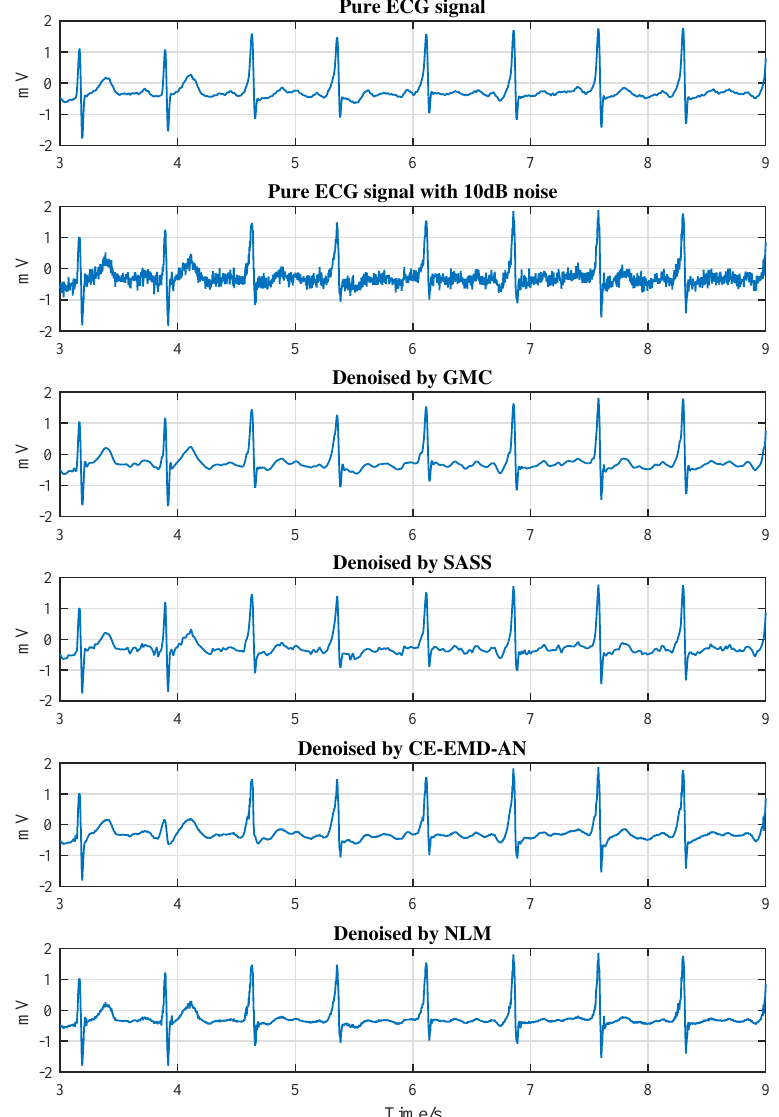
Figure 14. Comparison of waveform outputs of different algorithms for an arrhythmia ECG signal (No.230 in the MIT-BIH